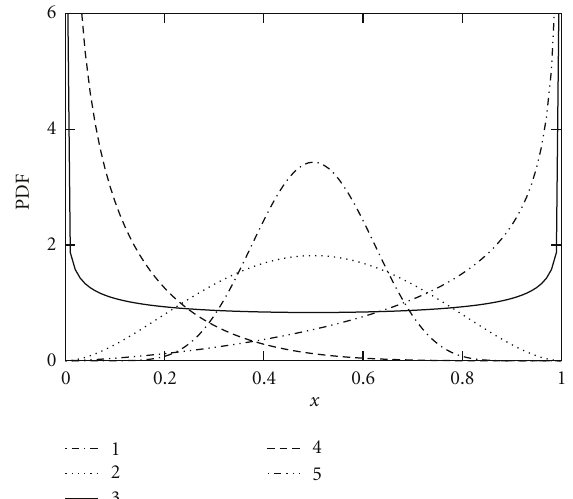
Figure 1: Beta-function PDFs calculated using (3) for (1) ξ = 0 . 5 and g = 0 . 05, (2) ξ = 0 . 5 and g = 0 . 15, (3) ξ = 0 . 5 and g = 0 . 40, (4) ξ = 0 . 1 and g = 0 . 15, (5) ξ = 0 . 8 and g = 0 . 25.